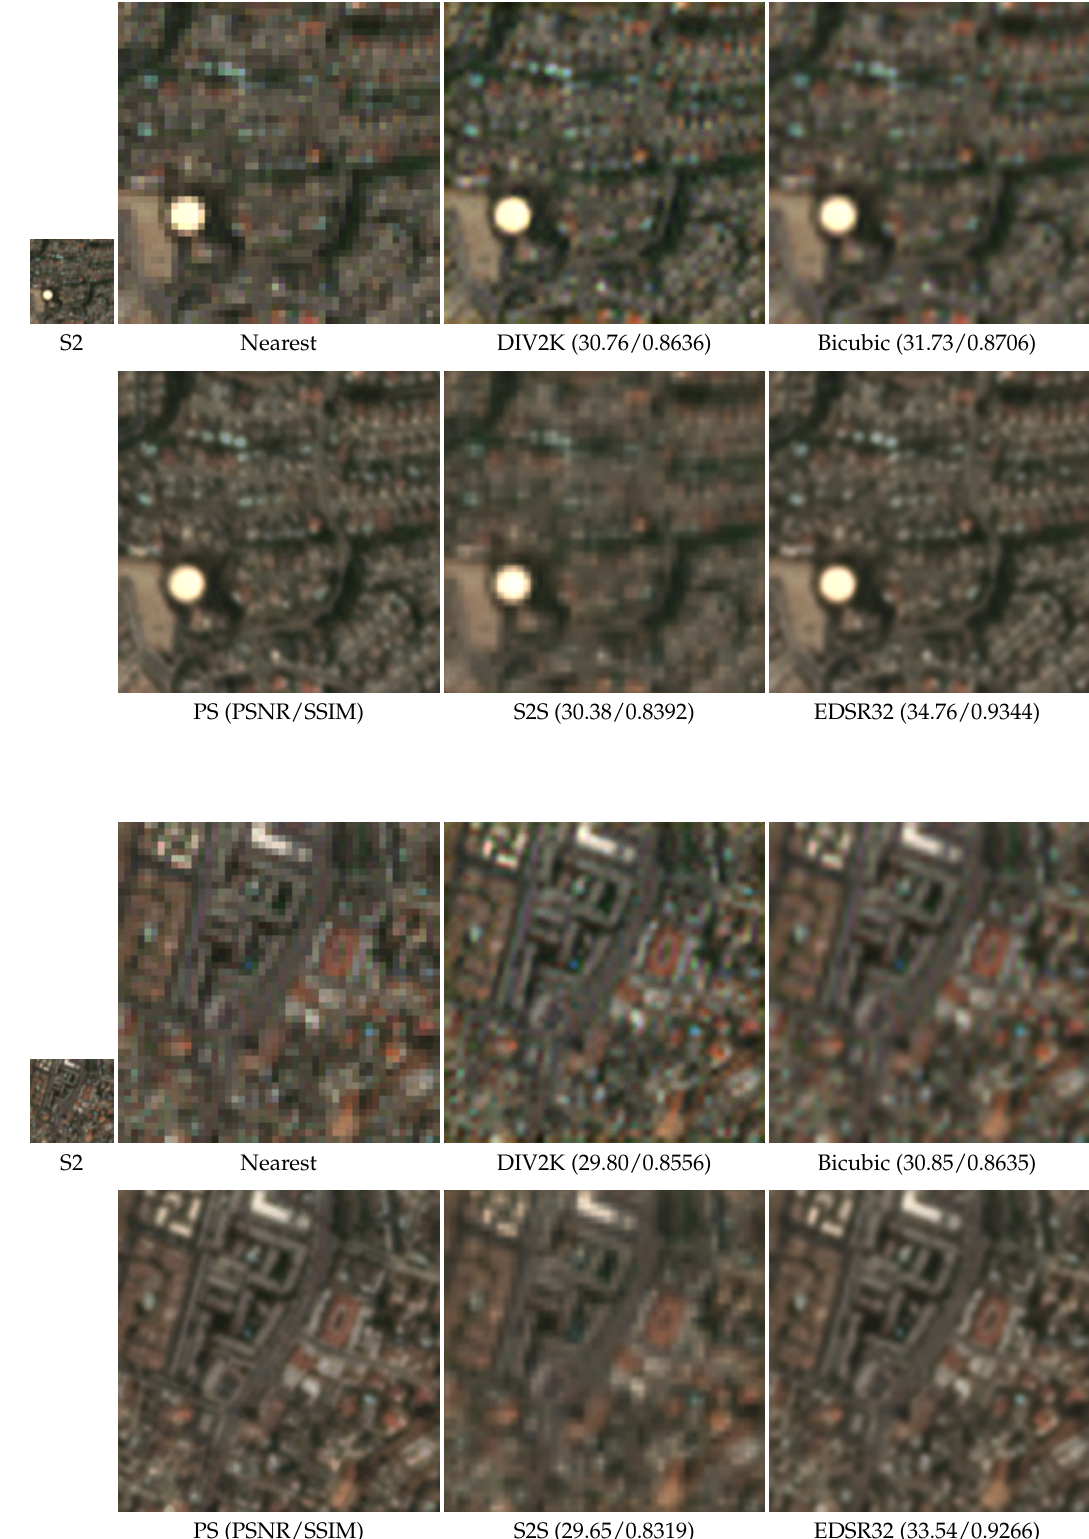
Figure A4. Visual comparison (RGB) of the baseline and EDSR32 models (tiles from test